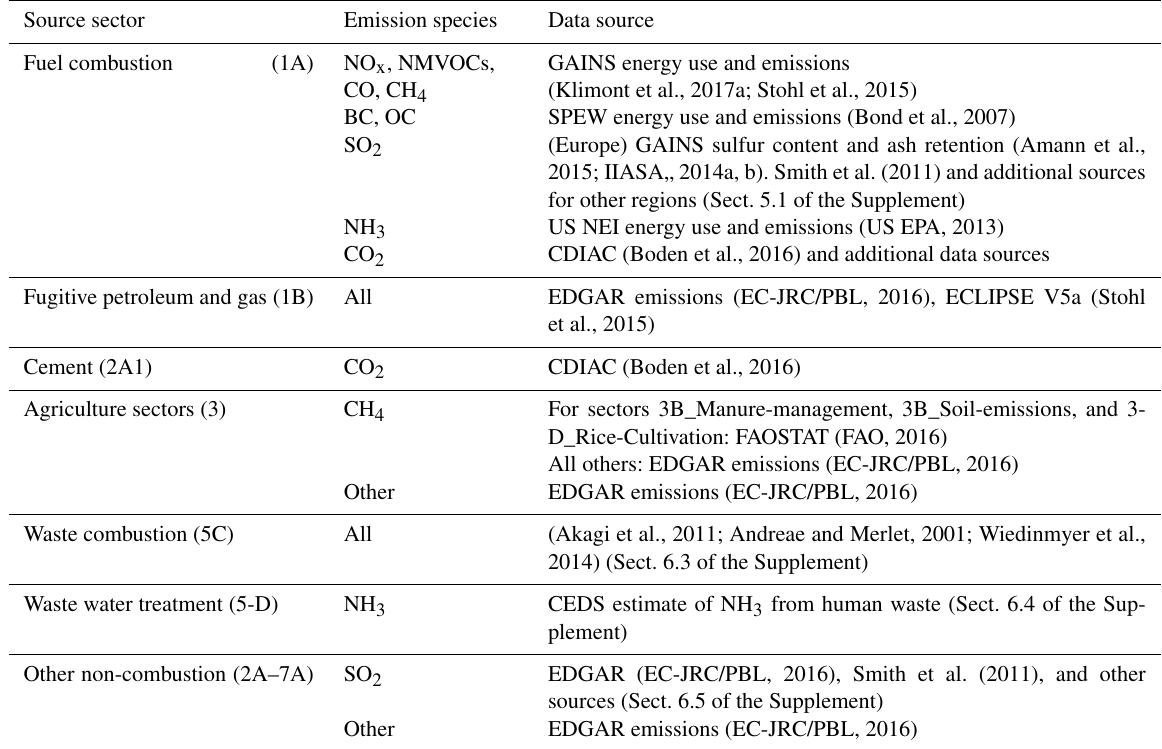
Table 2. Data sources used to estimate default emission factors for fuel combustion and default emissions from non-combustion